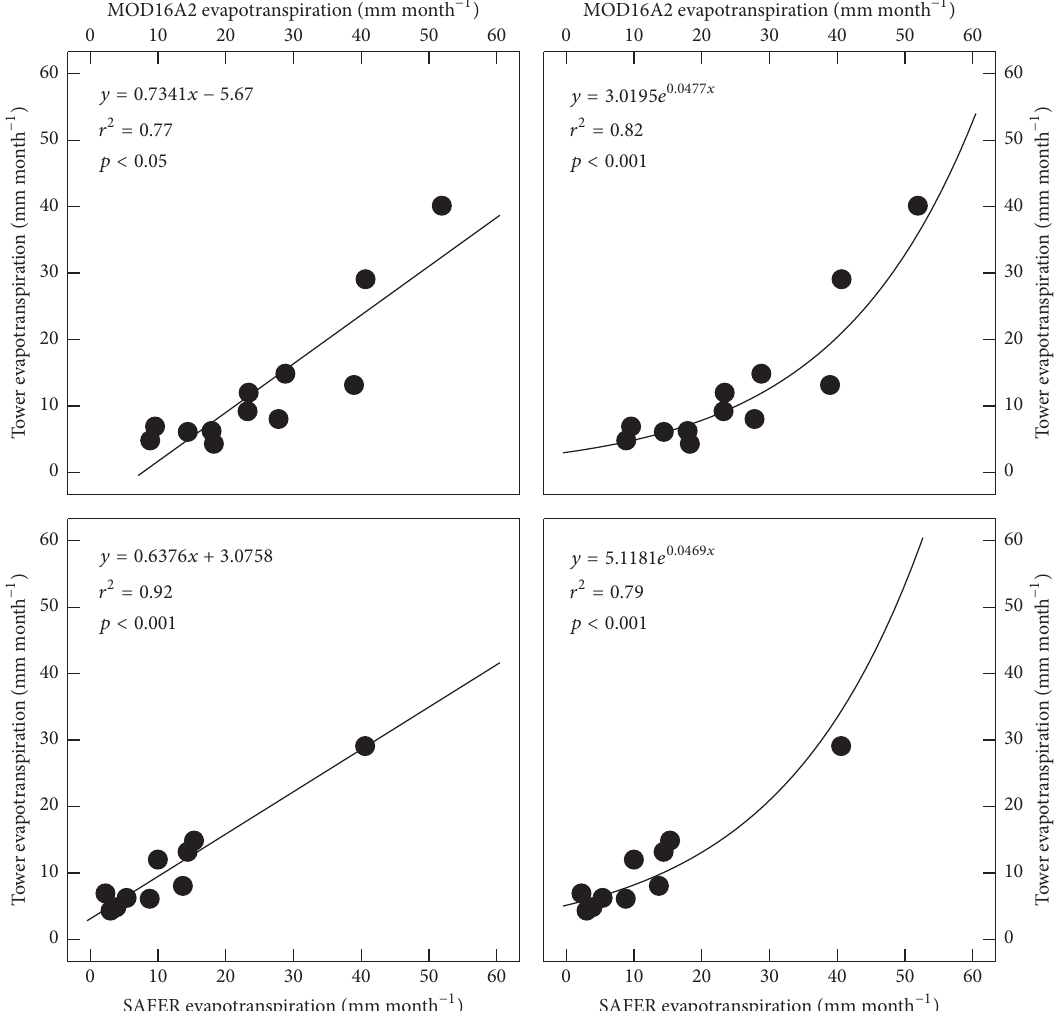
Figure 4: Monthly linear and exponential regression of MOD16A2 evapotranspiration (superior part) and SAFER evapotranspiration (inferior part) versus evapotranspiration from a Flux tower installed in an area of Caatinga at Embrapa Semi´arido, which is a research station of the state of Pernambuco, Brazil, for the year of